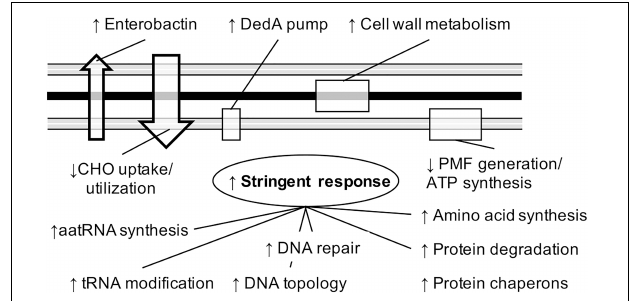
FIGURE 5 | A schematic model describing physiological adaptation strategies of strains exhibiting porin alterations during growth with sublethal concentrations of ertapenem based on results of this study is shown. Arrows indicate up-/down-regulation of genes encoding respective cellular processes during growth with the carbapenem. For explanations see text. PMF, proton motive force; CHO,